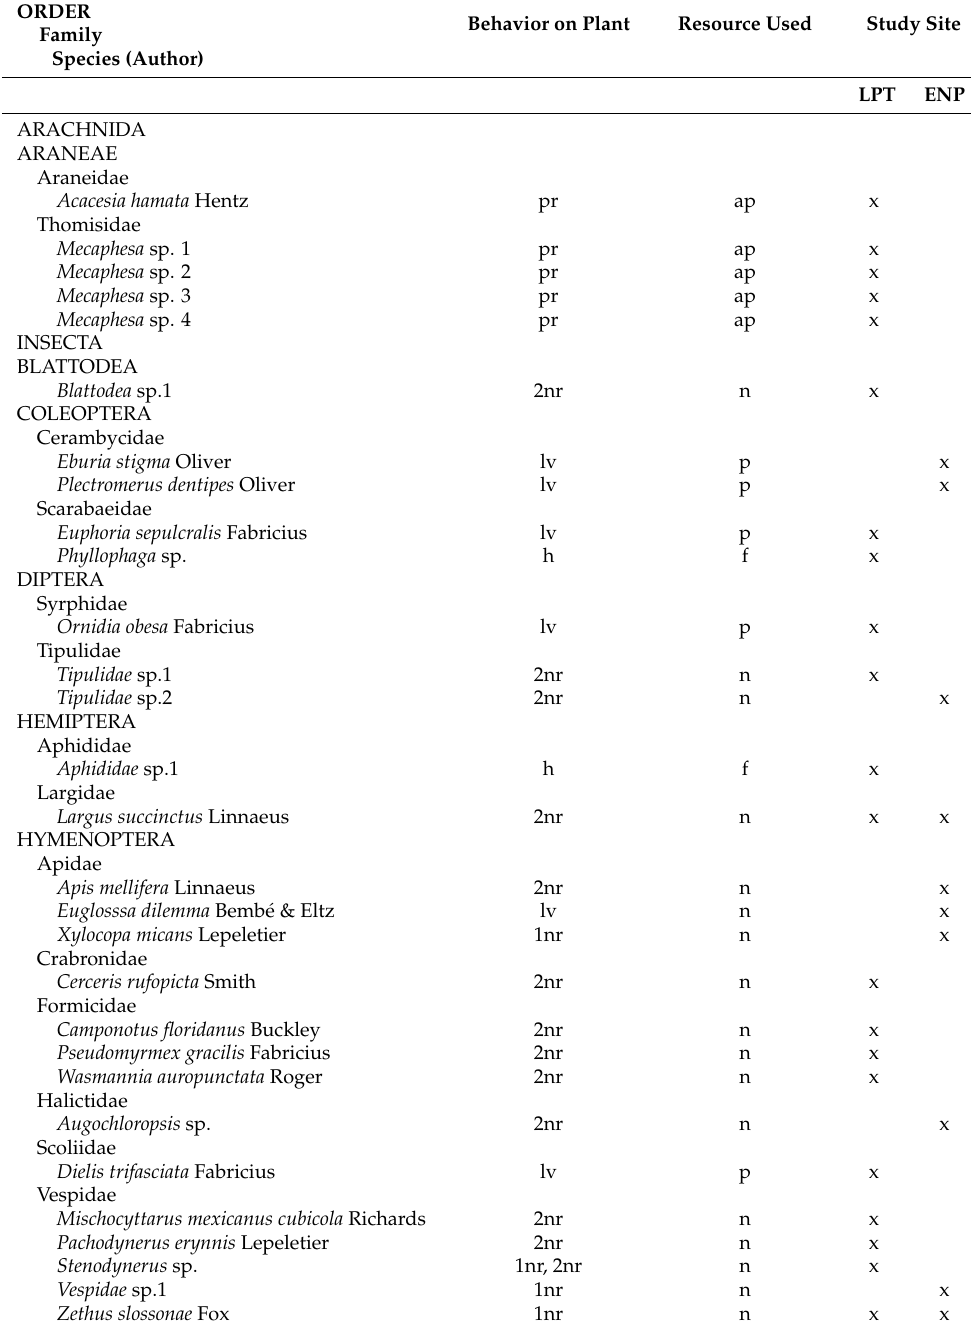
Table 1. Array of arthropods associated with Guettarda scabra , their behaviors, and plant resources used at two pine rockland sites (Larry and Penny Thompson Memorial Park: LPT; and Long Pine Key, Everglades National Park: ENP) in south Florida. Observed behaviors abbreviated as follows: preda- tion on other arthropods (pr), legitimate visitation (lv), primary nectar robbing (1nr), secondary nectar robbing (2nr), and herbivory (h). Plant resources used by visitor abbreviated as follows: arthropod prey (ap), nectar (n), pollen (p), floral tissue (f), and leaves (l). Asterisks signify caterpillar